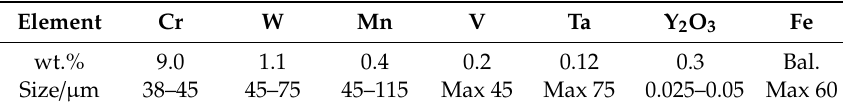
Table 1. Chemical composition of oxide dispersion-strengthened (ODS) Eurofer and the powder size used in this study.